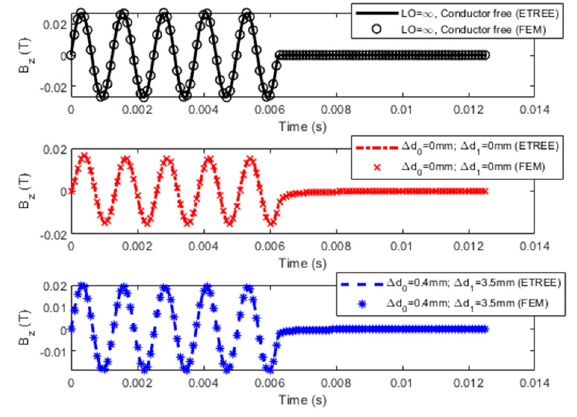
Figure 3. Predicted PMEC signals and comparison with finite element modeling (FEM) results. Table 1. Parameters of the PMEC probe.